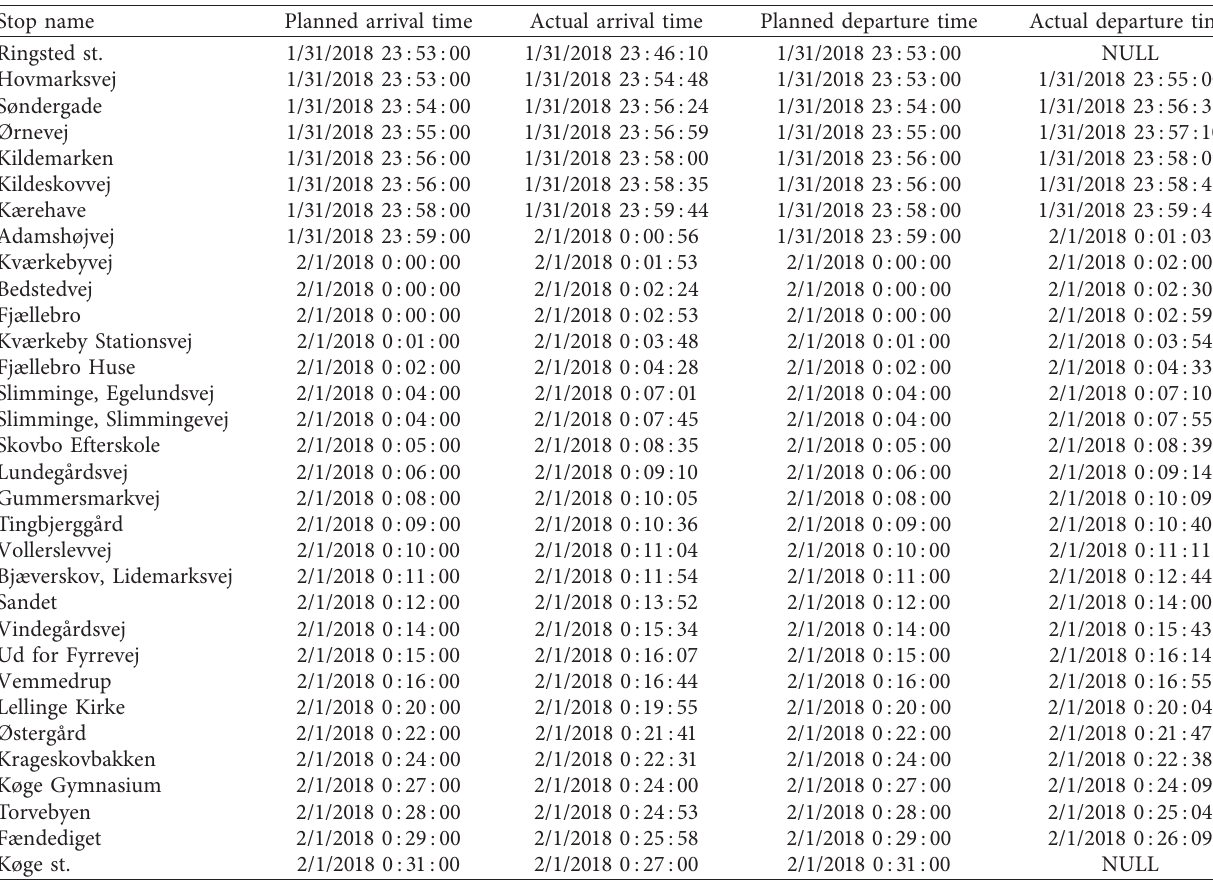
Table 1: Stored data of predicted and actual arrival and departure times for all stops of a bus journey (identical planned times for consecutive stops denote the presence of optional stops).